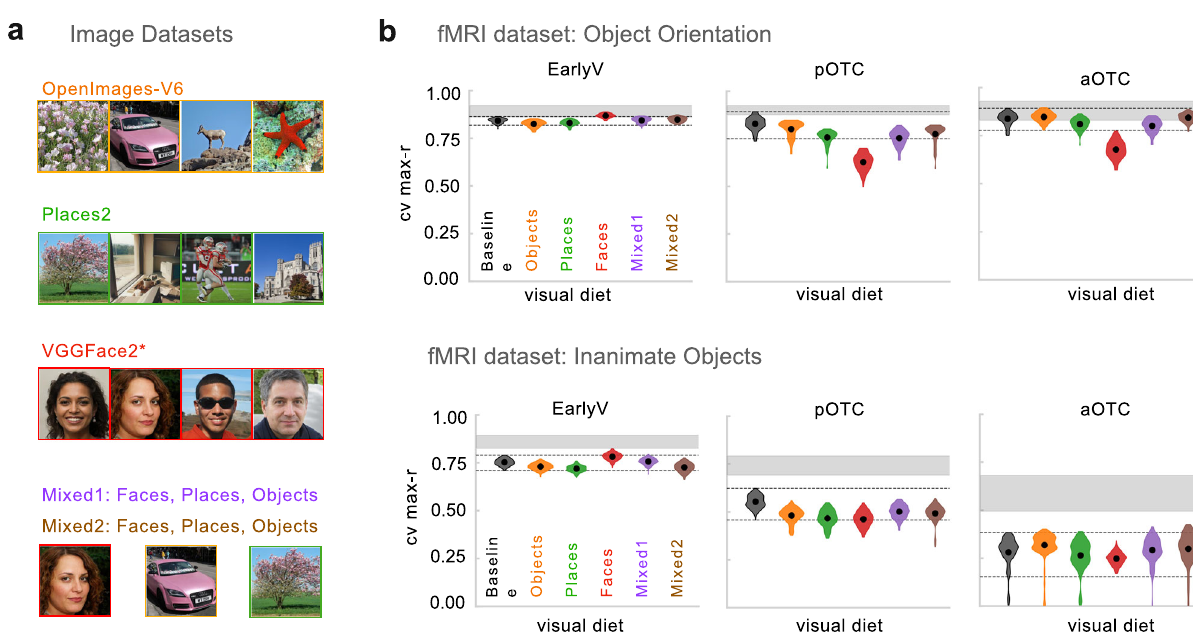
Fig. 3 Consequences of variation in the visual diet. a Example images in the style of each of dataset are shown. For OpenImagesV6 and Places2, similar images were found from commons.wikimedia.org. For VGGFace2, images were generated from thispersondoesnotexist.com. b The cross-validated maximum correlation (cv max-r) between model RDMs and neural RDMs for each dataset (rows), and each brain region (columns). Mean scores are shown with a black dot at the center of a mirrored density plot (violin plot) showing the distribution of correlations across all split-halves (distributions are cutoff at ±1.5 IQR, interquartile range, Q3-Q1). The dashed black lines indicate the ±1.5 IQR range for the matched baseline IPCL model trained on ImageNet. Source data are provided as a Source Data fi